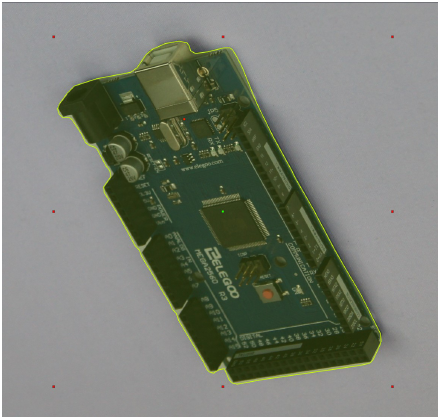
Figure 2. Labeling images for YOLOv5 semantic segmentation algorithm using Roboflow smart polygonal